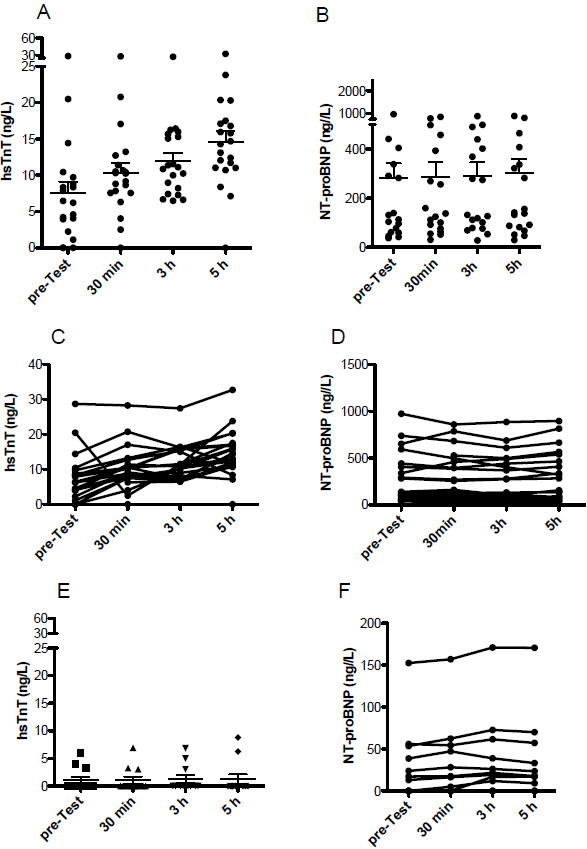
Plasma levels of hsTnT increased time-dependently after exercise (Scatter Blot A and individual patients C), whereas levels of NT-proBNP remained constant (Scatter Blot B and individual patients D) in patients with PAH. HsTnT (E) and NT-proBNP (F) remained unchanged in the healthy control cohort after exercise.